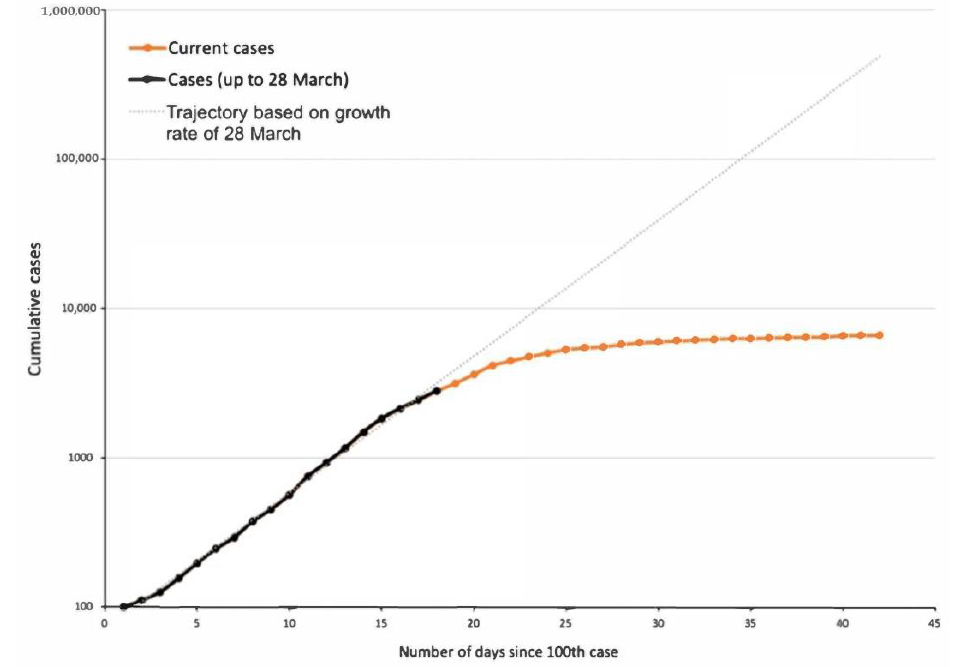
Figure 2. Cumulative growth of COVID-19 cases in Australia (shown since 100th case). The dotted line represents the possible trajectory of COVID-19 cases based on the growth rate of 28 March 2020. Last updated on 20 April 2020